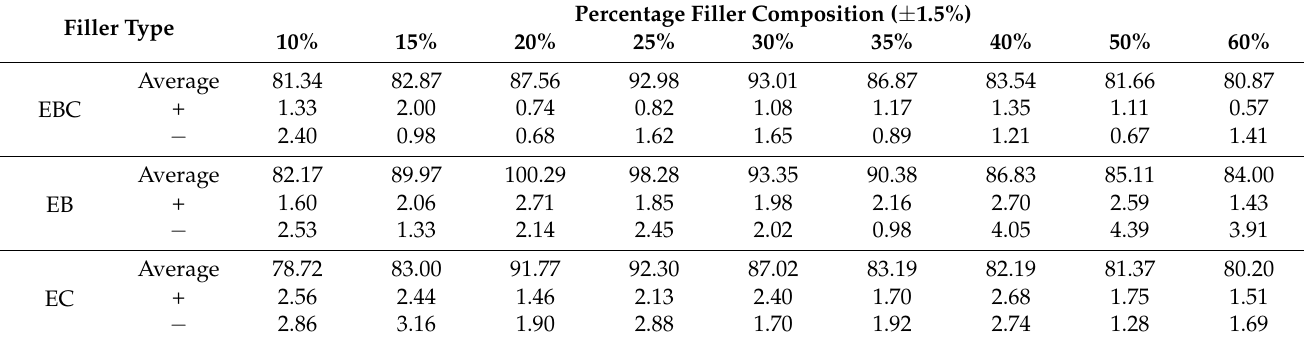
Table 10. Summary of compressive strength values for EBC, EB, and EC. For EBC, the highest compressive strength is 93.10 MPa, and it occurs at 30% filler